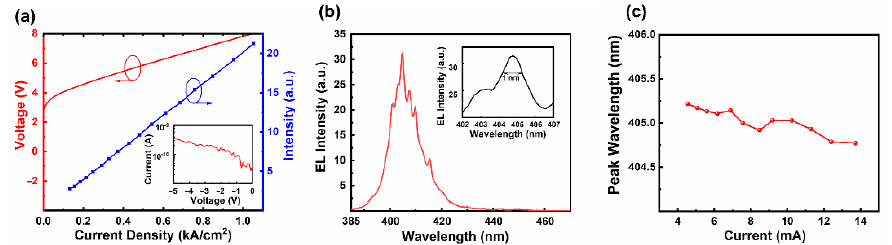
Figure 4. ( a ) Measured L–I–V characteristics of the as-fabricated GaN-based RCLED, and the inset showing leakage current under a reverse bias. ( b ) EL spectrum of the RCLED at an injection current of 7 mA, and the inset showing the dominant cavity mode with a linewidth of approximately 1 nm. The silicon detector was located 1 cm directly above the device and collected only a portion of the output power. ( c ) The peak wavelength of RCLED at various injection currents.